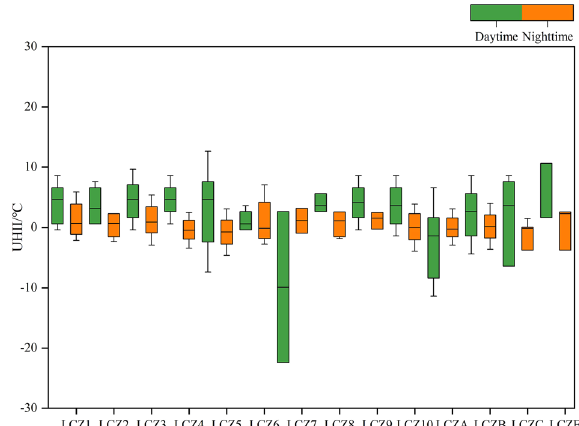
Fig. 3 The difference of day and night UHII corresponding to each LCZ types. NUHII is the nighttime UHII and DUHII is the daytime